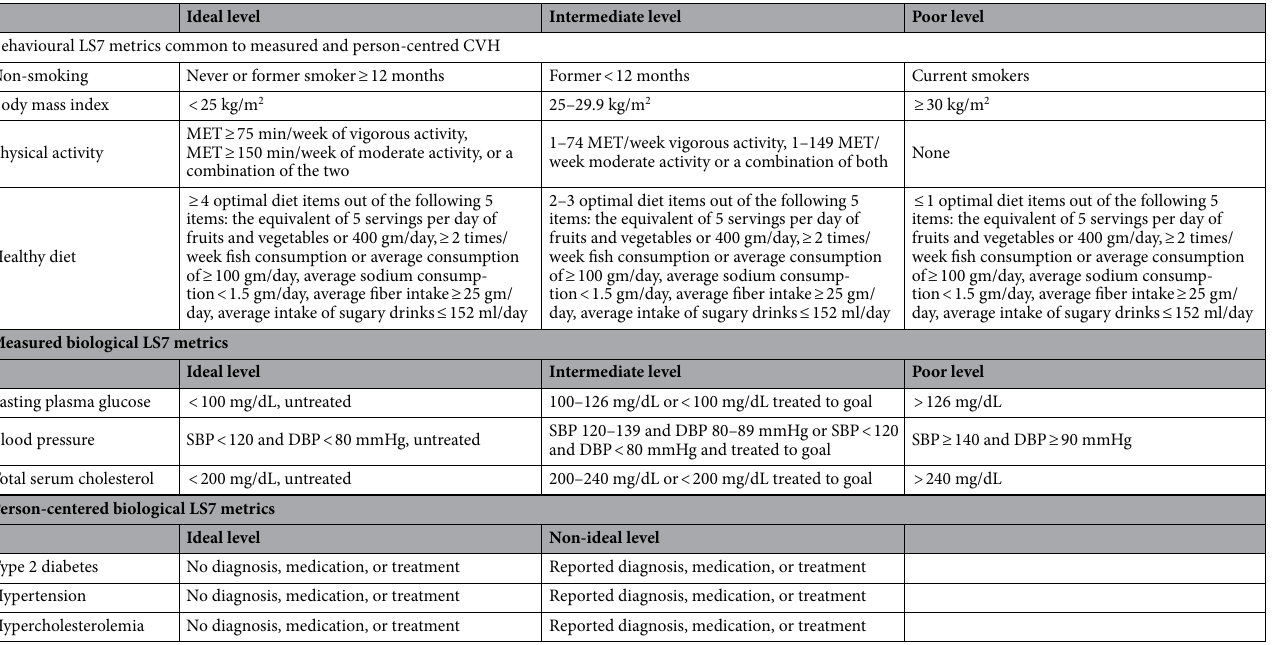
Table 1. Definitions of measured and person-centred cardiovascular health Life’s Simple 7 metrics. MET metabolic equivalents min/week, SBP systolic blood pressure, DBP diastolic blood